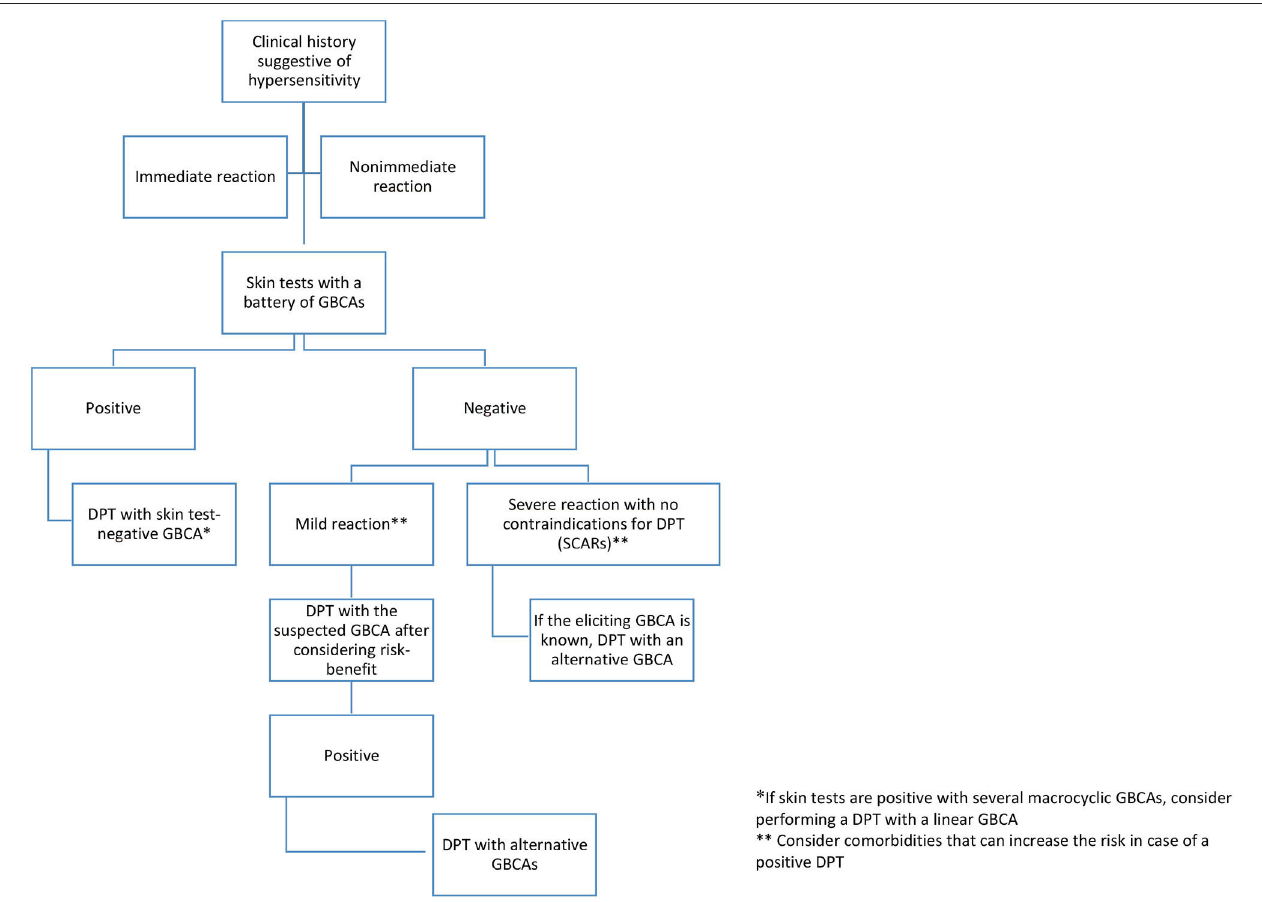
FIGURE 3 | Algorithm for the diagnosis of hypersensitivity reactions to GBCAs. DPT, drug provocation test; GBCA, gadolinium-based contrast agent; SCAR, severe cutaneous